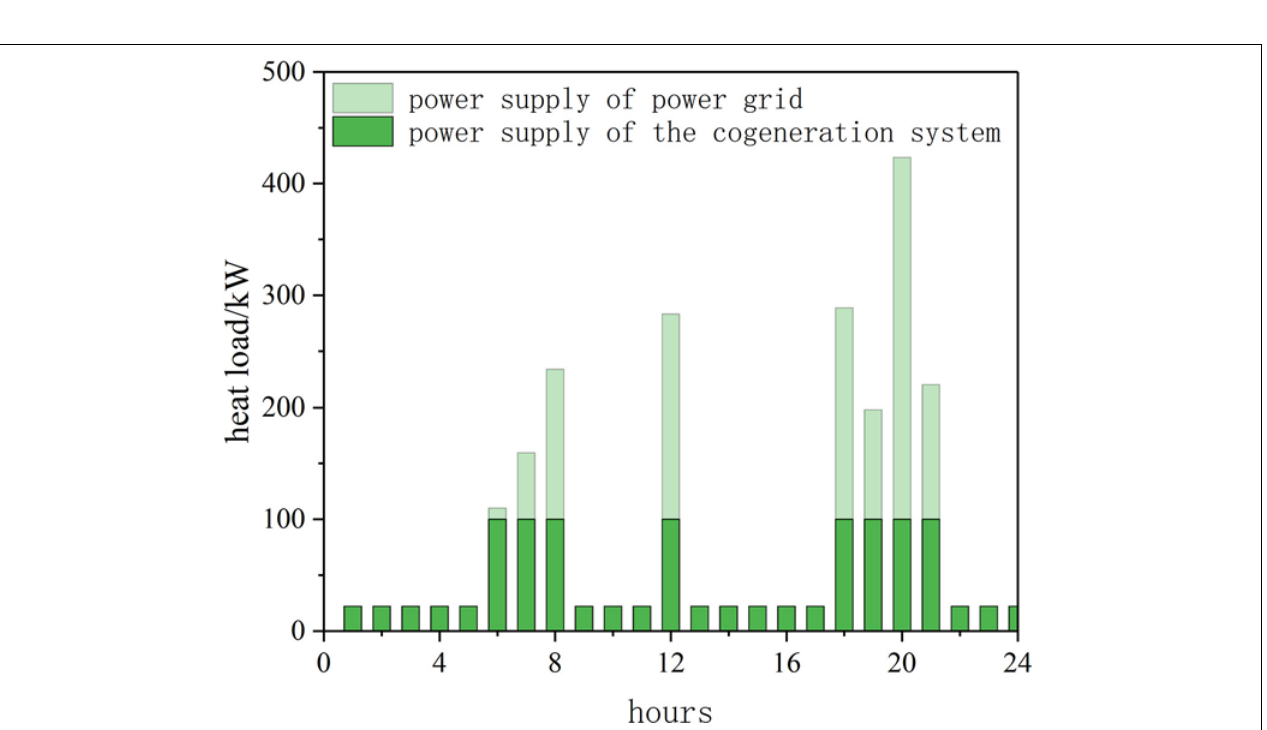
FIGURE 10 | Power supply on a typical winter